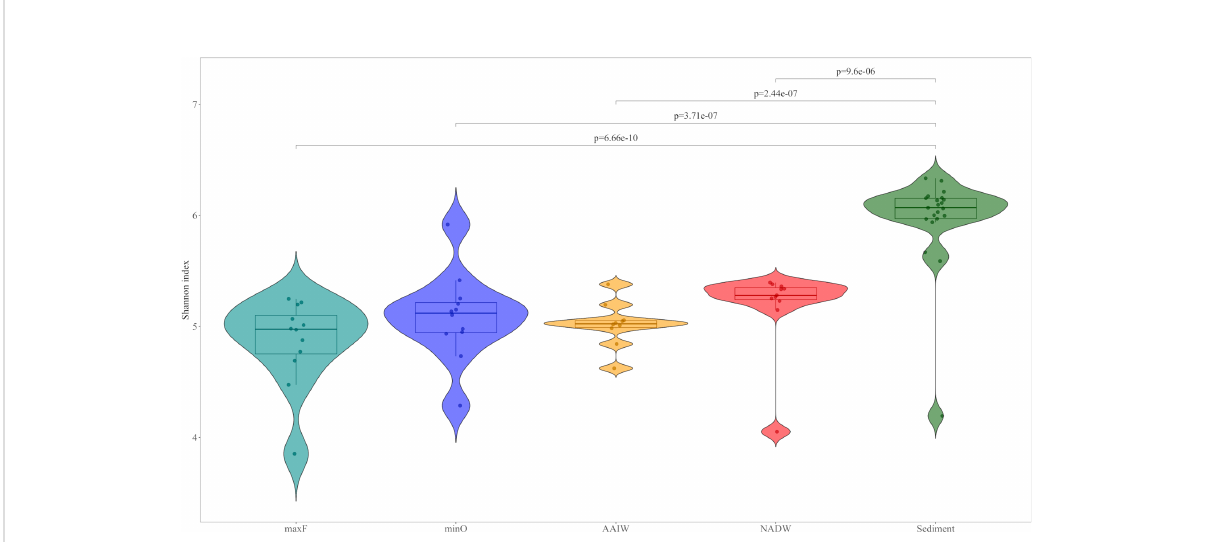
FIGURE 3 Violin representation of the Shannon diversity Index for water and sediment environments. The results are presented according to water masses: maxF, minO, AAIW, NADW and sediments. The upper lines show the differences between water masses and sediment, based on two- way ANOVA followed by Tukey ’ s multiple comparison of means (p